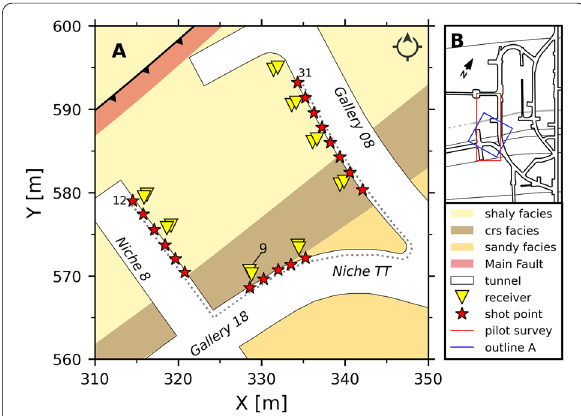
Fig. 1 Map of the central part of the Mont Terri Laboratory ( A ) which covers the geological units: shaly, sandy, carbonate-rich sandy (crs) facies and the Main Fault (MF) at a height of 515 m. The geological units dip towards SSW with ∼ 45 ◦ . The markers represent the receivers (yellow triangles) and shot points (red stars). The gray dotted line follows the shot point profile, starting at SP12 and ending at SP31 (SP23 is not part of this profile). Receiver 9 is marked for the example receiver gather shown in Fig. 3. The sketch of the URL ( B ) shows the location of the pilot survey (red) and the area for the tomographic study (blue)